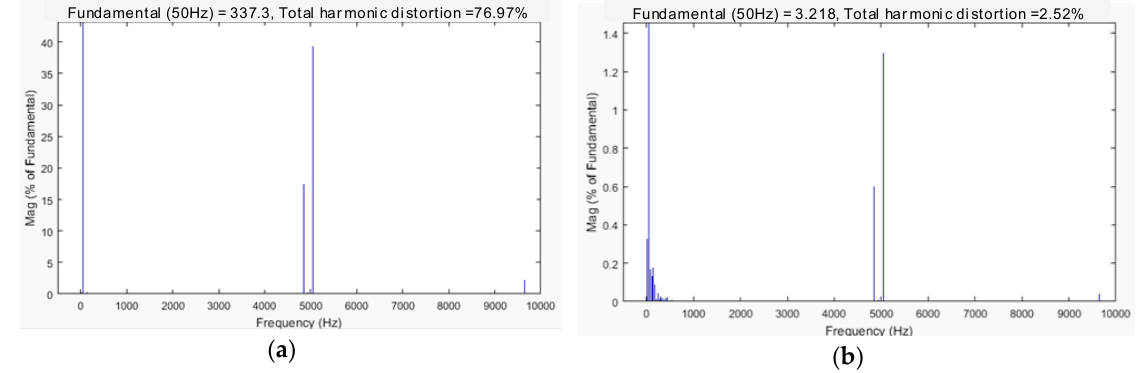
Figure 6. Harmonic composition of the load: ( a ) voltage; and ( b ) current.